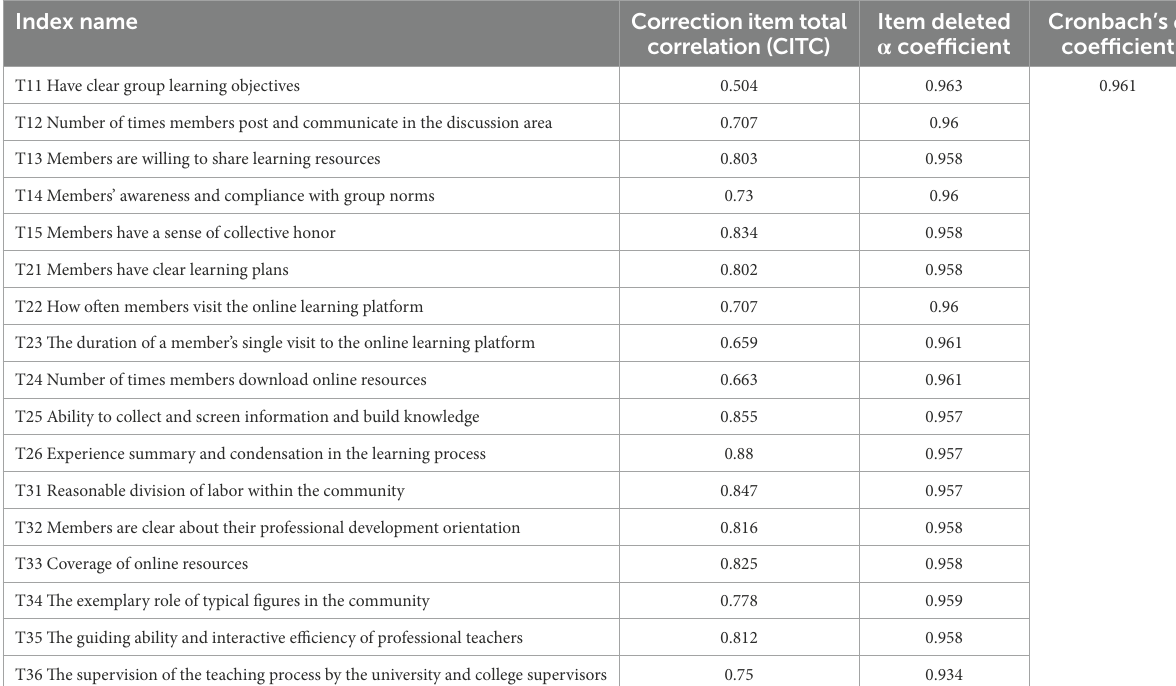
TABLE 4 Reliability